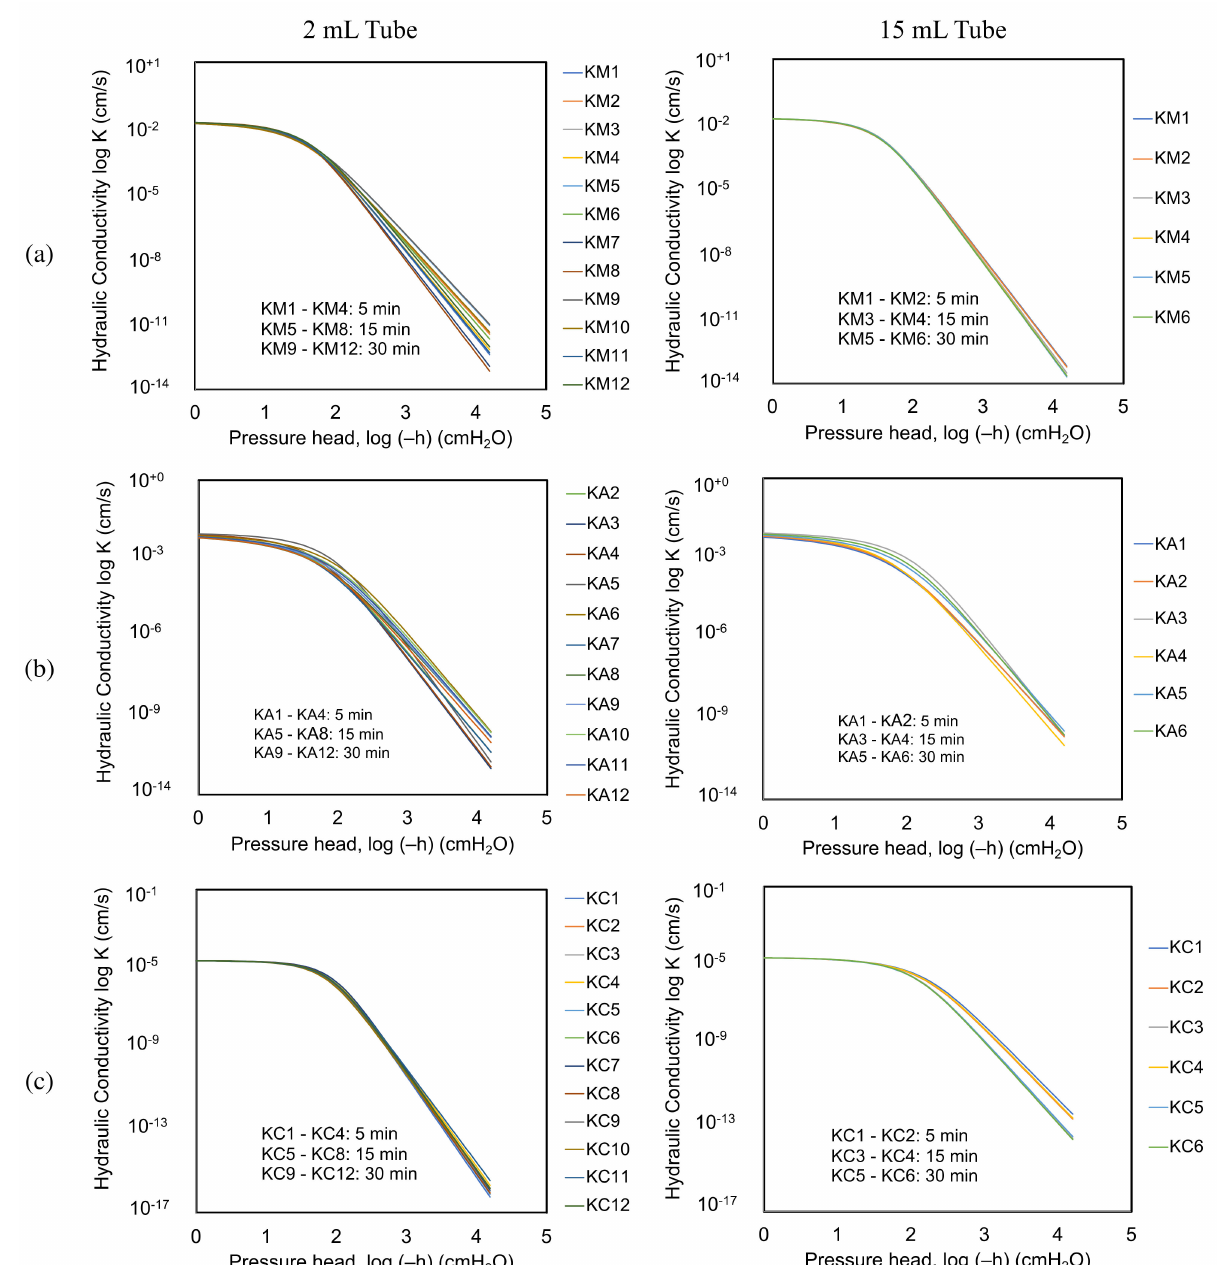
Figure 9. Optimized hydraulic conductivity functions after setup of constant saturated hydraulic conductivity K s of 2 mL and 15 mL tubes: ( a ) Decomposed granite soil (Masa soil); ( b ) Volcanic ash soil (Andisol soil); ( c ) Paddy